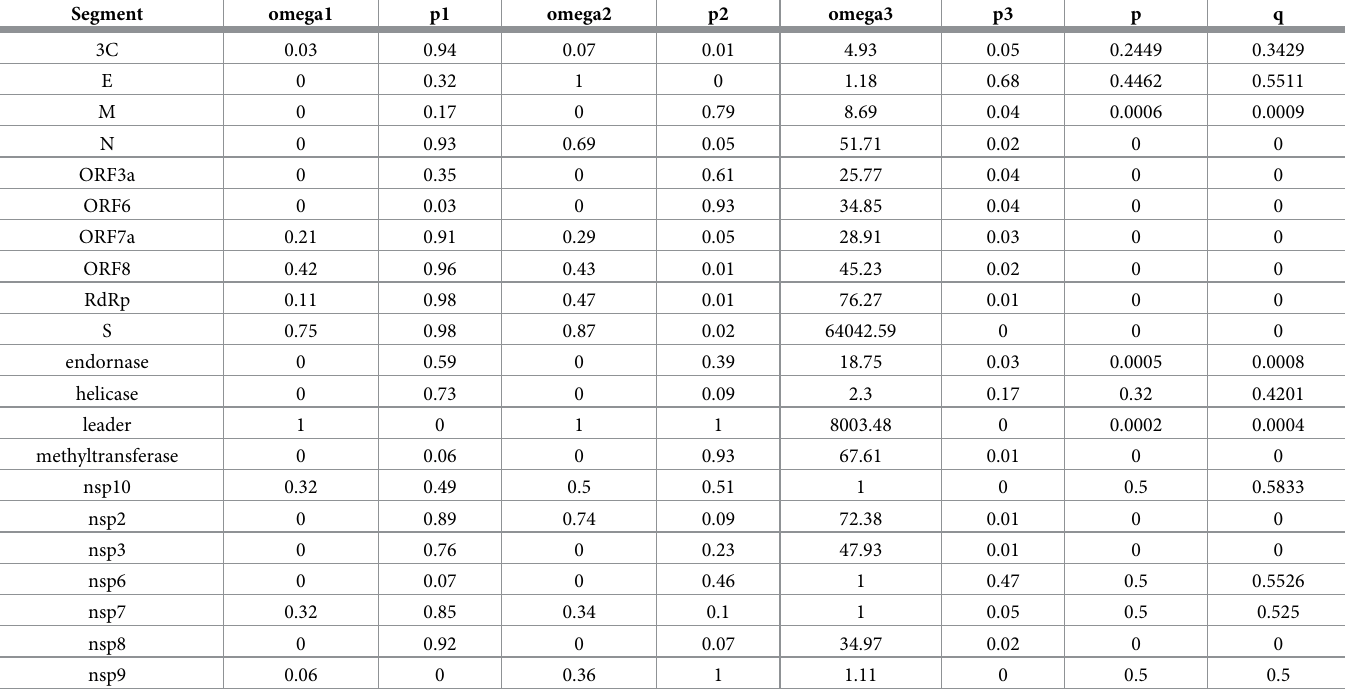
Table 2. BUSTED[S] selection results on the BA.5 SARS-CoV-2 clade across